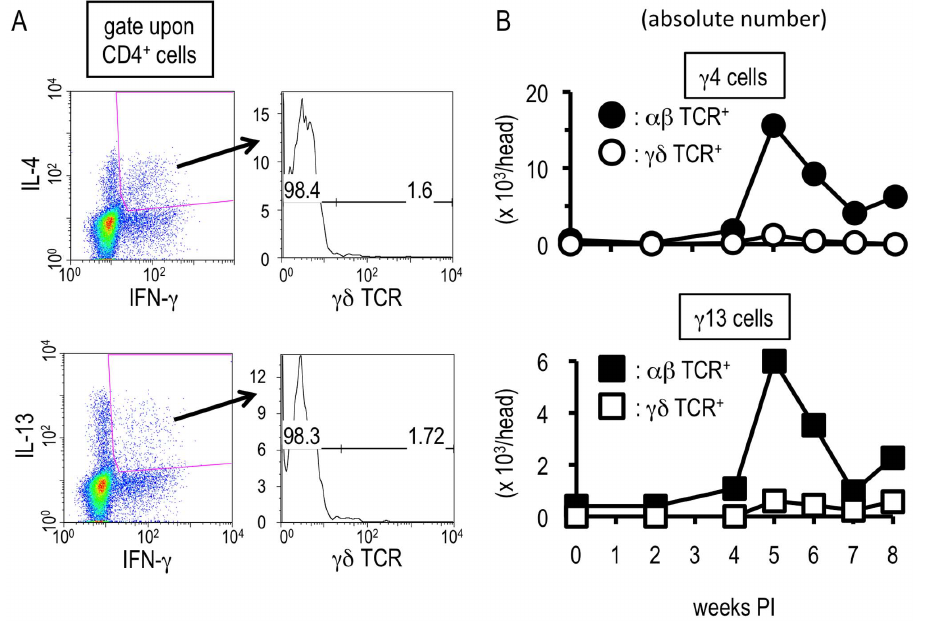
Figure 6. Hepatic ab T cells are the responsible cells showing the unconventional cytokine profiles. Hepatic lymphocytes were isolated from S. mansoni -infected mice and flowcytometry was conducted after TCR ligation. (A) Expression levels of cd TCR on CD4 + c 4 cells or c 13 cells were analyzed with the hepatic lymphocytes isoleted at 6 weeks PI. The values in the right insets indicate percentages of cd TCR-positive or –negative population in CD4 + c 4 or c 13 cells. This experiment is a representative of four independent experiments. (B) The absolute numbers of c 4 cells (upper graph) or c 13 cells (lower graph) in ab TCR- or cd TCR-potitive population were investigated. Similar results were obtained in three independent experiments.